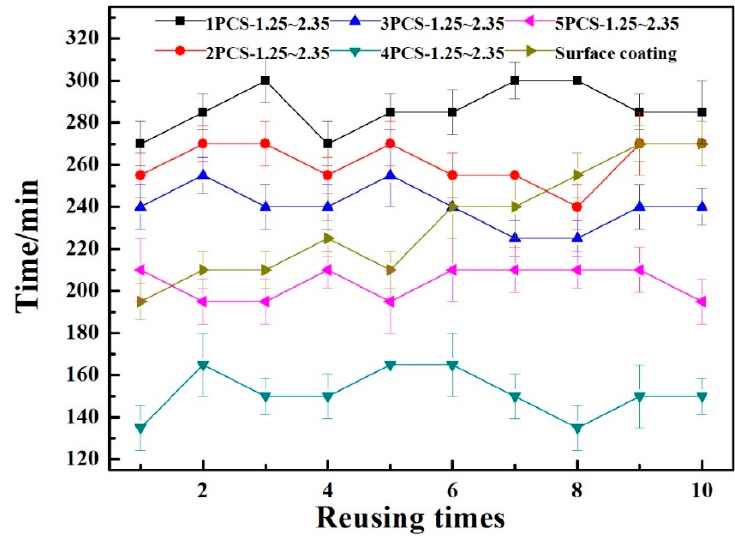
Figure 10. Time of fully degradation of 2 μ L benzene by mPCS-1.25~2.35 (m = 1~5 g/L) for 10 cycles.